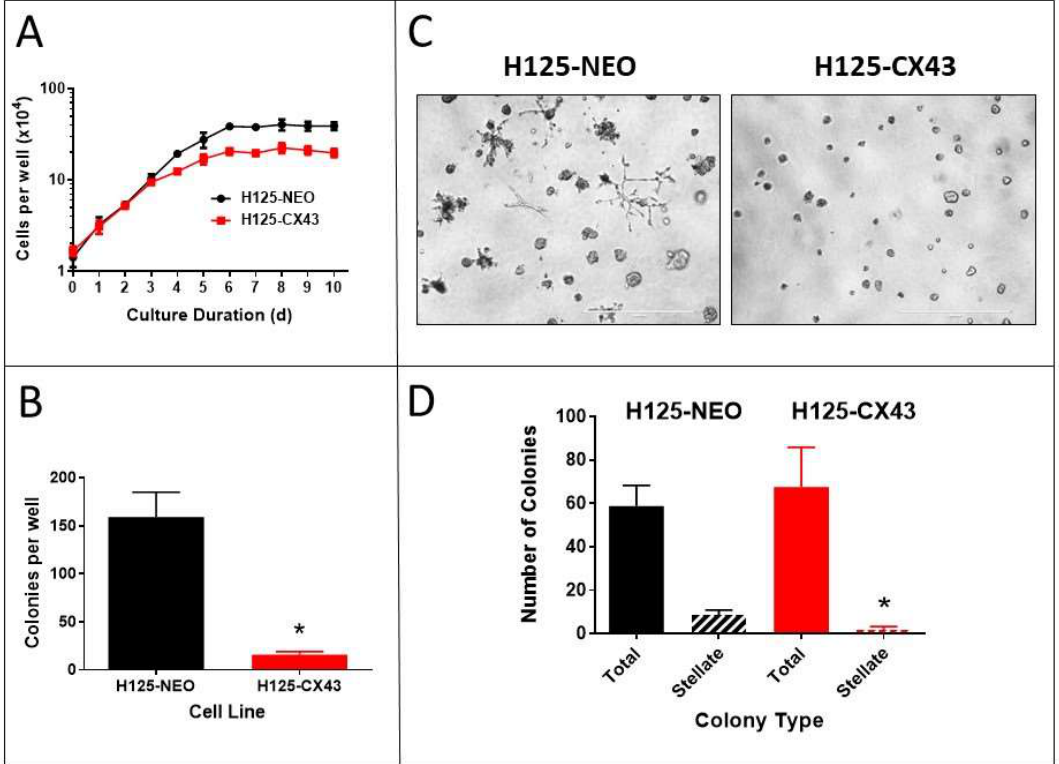
Figure 3. Connexin43 reduces the proliferation of H125 cells. ( A ) Growth of H125-NEO and H125- CX43 cells on plastic (mean ± S.D., n = 4 replicate experiments), ( B ) in soft agar, and ( C ) in Matrigel (scale bars: 1000 µm). ( D ) The number and types of colonies obtained after growth in Matrigel were enumerated. ( B , D ) * p < 0.01 compared to H125-NEO, Student’s t -test, mean ± S.D., n = 3 replicate